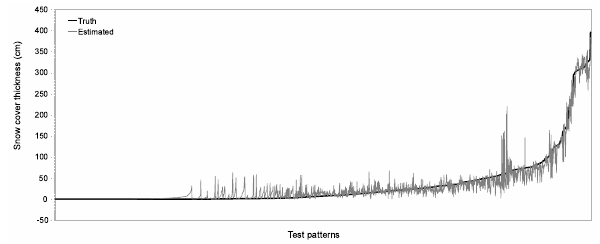
Fig.3. Estimatedsnowcoverthicknessversusmeasuredvaluesin ascendingorder. Fig. 3. Estimated snow cover thickness versus measured values in ascending